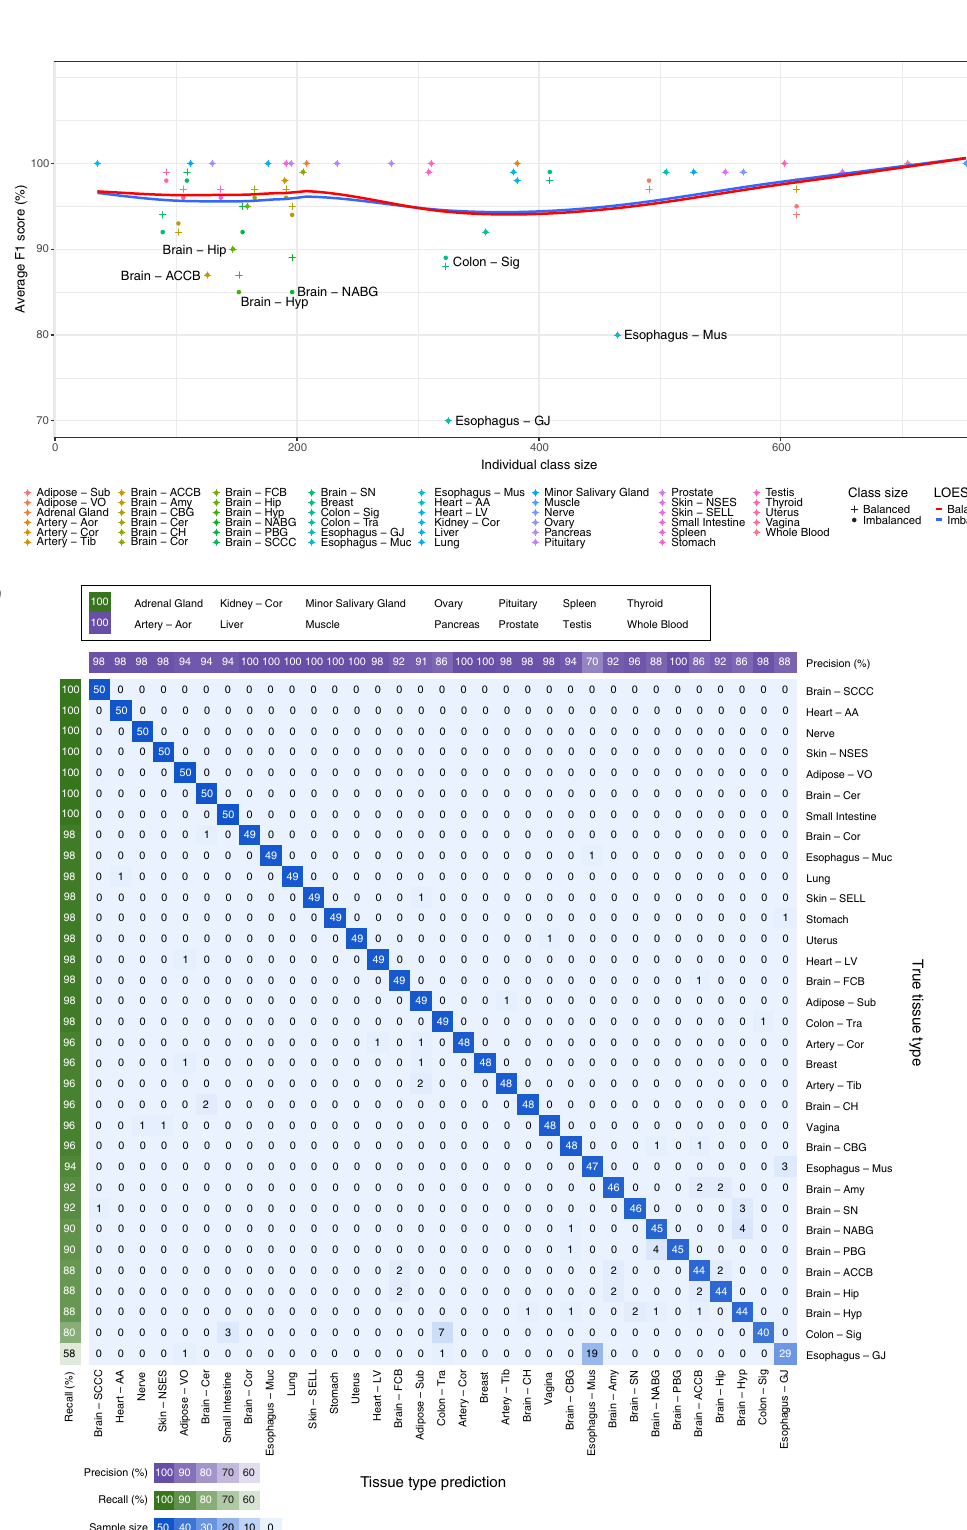
SHAP genes not identified as significant by edgeR (Fig. 4a). Pathway analyses of the 2423 SHAP genes and 7854 edgeR genes revealed similar pathways, including enrichment in GPCR ligand binding, neuronal system, extra- cellular matrix organization and keratinization pathways (Supplementary Fig. S6a, b). At the individual tissue level, when we compared the top 103 ranked genes identified by SHAP per tissue (4841 genes) with the most significant genes identified by edgeR within each tissue type (30,532 genes), we found the overlap amount varied, with 100% overlap in Testis, and < 25% overlap in Esophagus—GJ (Fig. 4b). In total, 1342 of the top 103 ranked genes identified by SHAP per tissue did not pass edgeR filters, as the majority of these genes (98.3%) passed